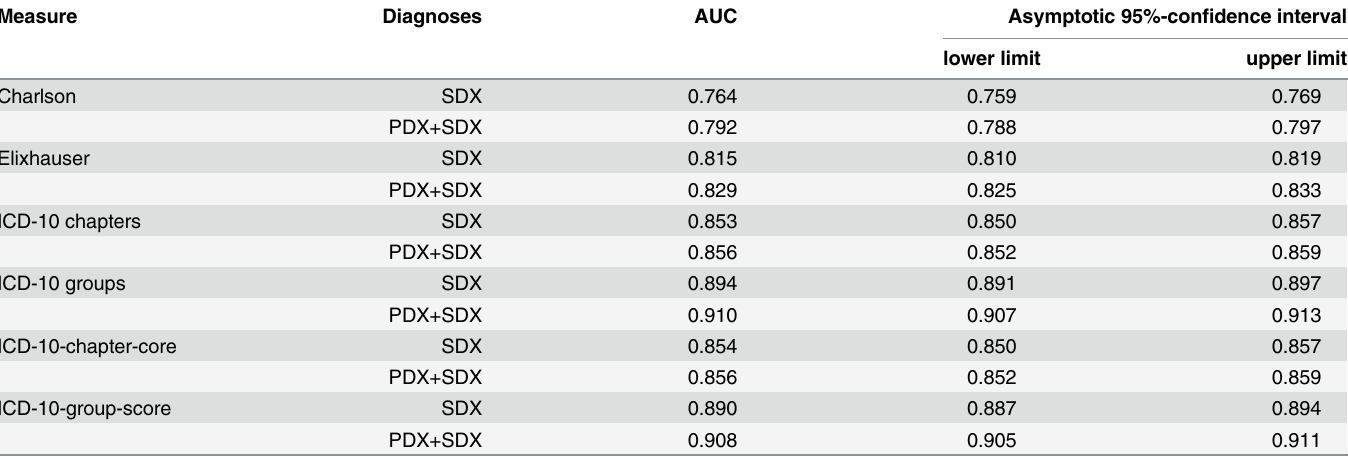
Table 4. Area under curve (AUC) from the